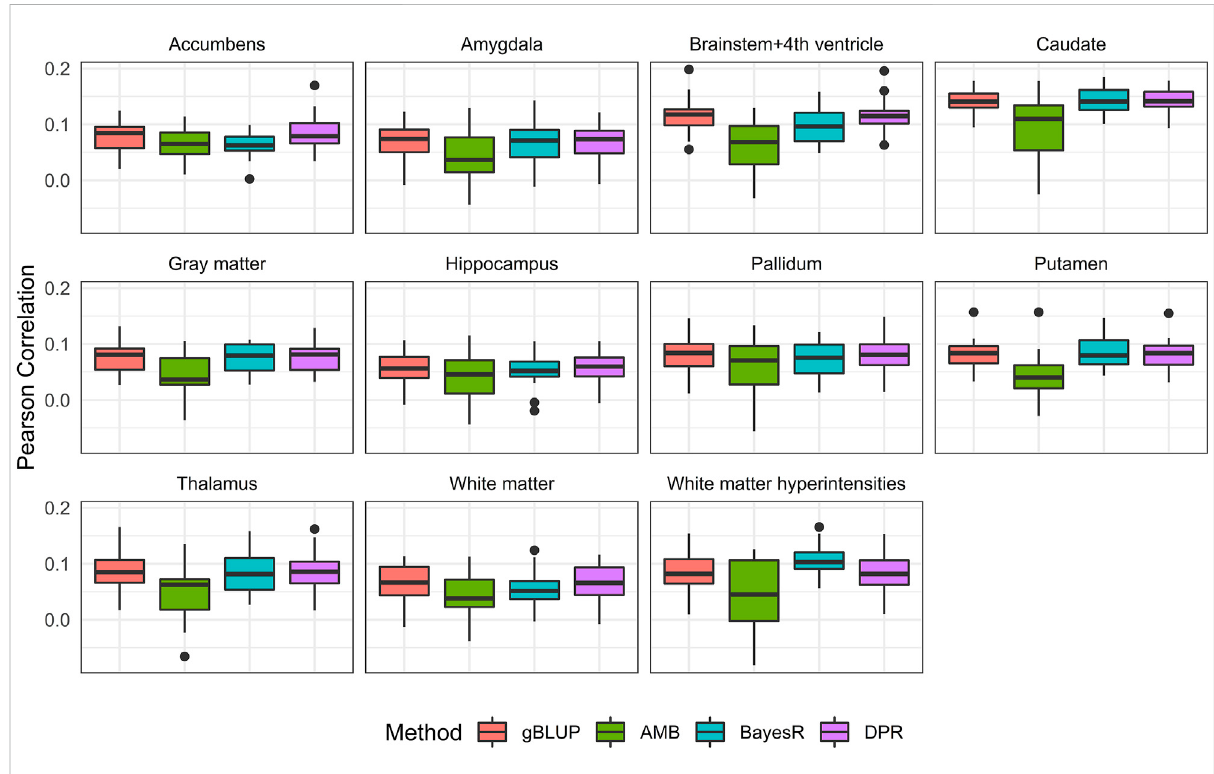
FIGURE 4 Pearson correlation for eleven brain imaging traits that are predicted using genetic variants from the UKB data. Methods include genomic best linear unbiased prediction (gBLUP), adaptive MultiBLUP (AMB), the latent Dirichlet process regression (DPR) and BayesR.